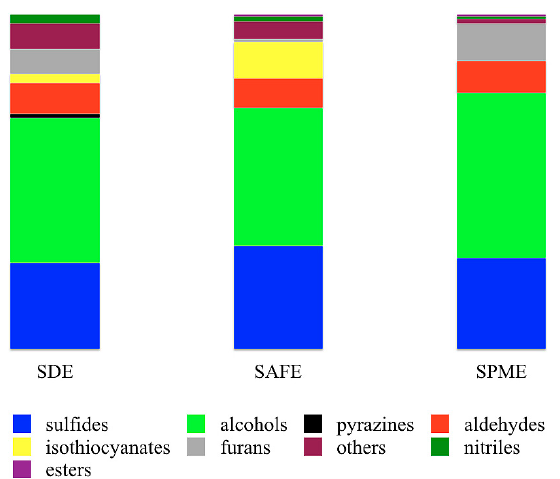
Figure 1. Main groups of volatile compounds in raw broccoli obtained using different extraction techniques. Graphs created based on area % of peaks identified using two-dimensional gas